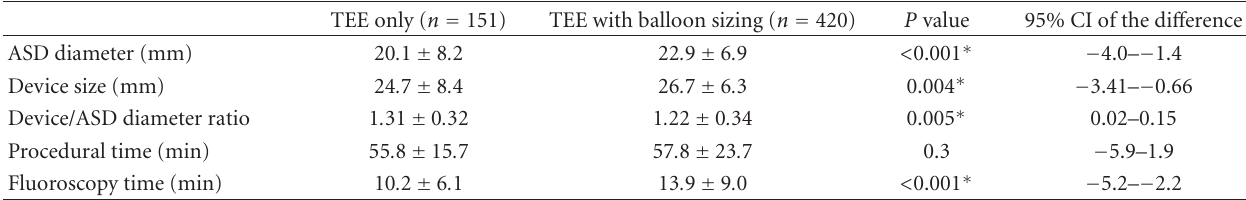
Values are expressed by mean ± SD. ∗ Statistical significance at P value <